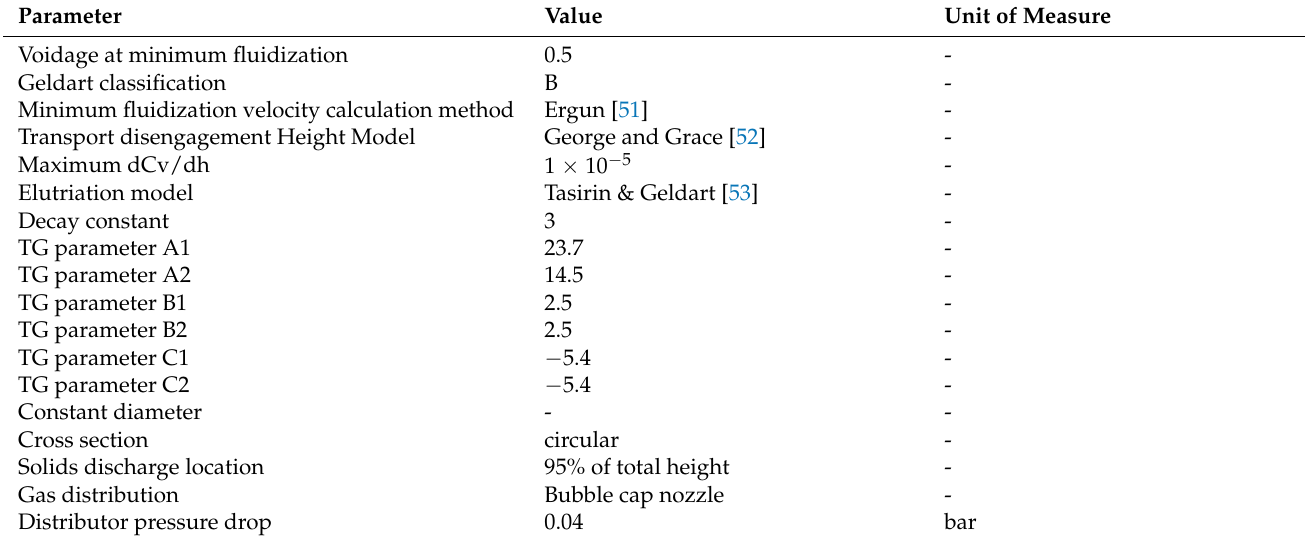
Table 5. Fluidized bed model input parameters.